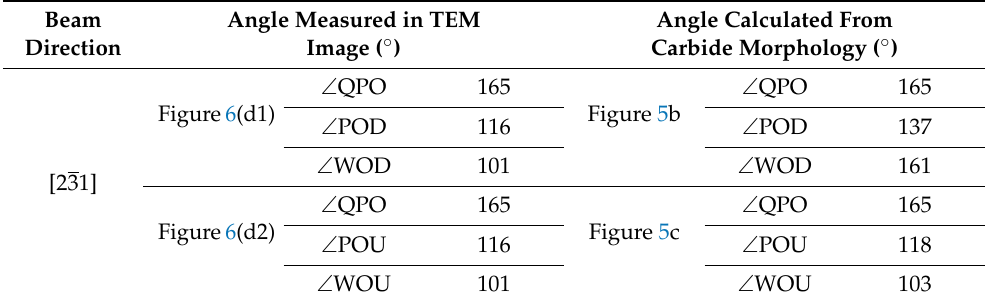
Table 4. Comparison of the angle measured in TEM image and that calculated from carbide morphol- ogy at [231] beam